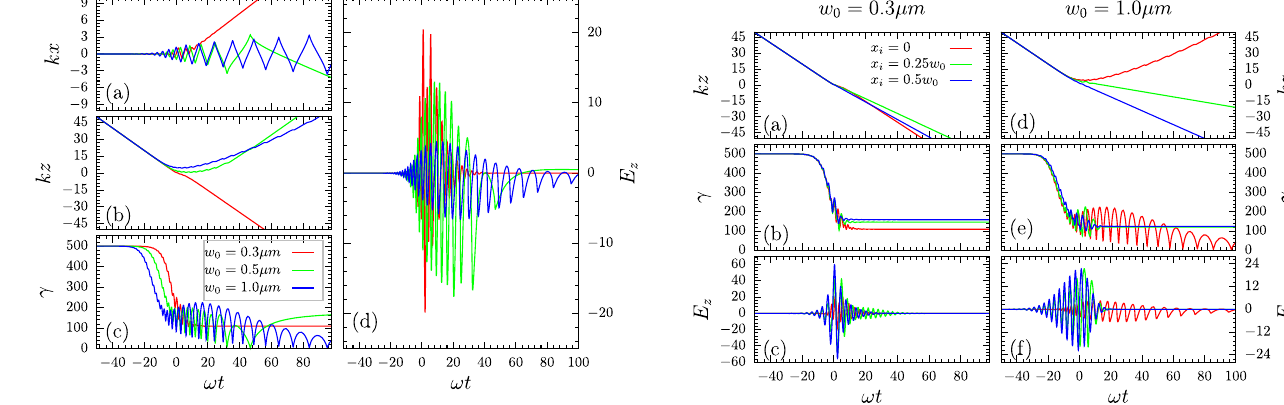
FIG. 16. Electron dynamics for three different impact param- eters, with RR included. In all cases the laser is modeled as a paraxial beam of peak intensity a 0 ¼ 200 , wavelength 0 . 8 μ m and duration 27 fs. The electron has an initial γ 0 ¼ 500 and is injected along the laser axis. The two lower panels show the = ω 0 m ) as experi- longitudinal electric field (normalized to eE z enced by the